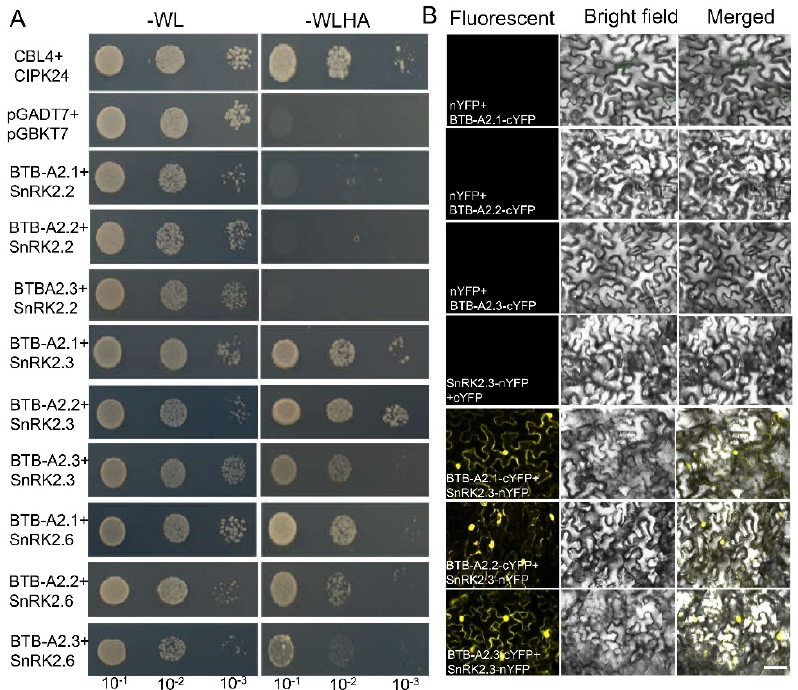
Figure 5. BTB-A2s interact with SnRK2.3. ( A ) The interactions of BTB-A2s with SnRK2.2, SnRK2.3, and SnRK2.6 by yeast two-hybrid assay. Saturated cultures were spotted onto SD-WL and SD-WLHA at different dilutions (10 −1 , 10 −2 , and 10 −3 ). The co-transformants of vectors CBL4-AD and CIPK24-BD were employed as positive controls, and co-transformants of the empty vectors pGADT7 and pGBKT7 were employed as negative controls; ( B ) The interactions of BTB-A2s with SnRK2.3 were analyzed using BiFC assay in N. benthamiana leaves. Columns from left to right are the fluorescent signal, bright field images, and merged images, respectively. Bar = 50 μm.